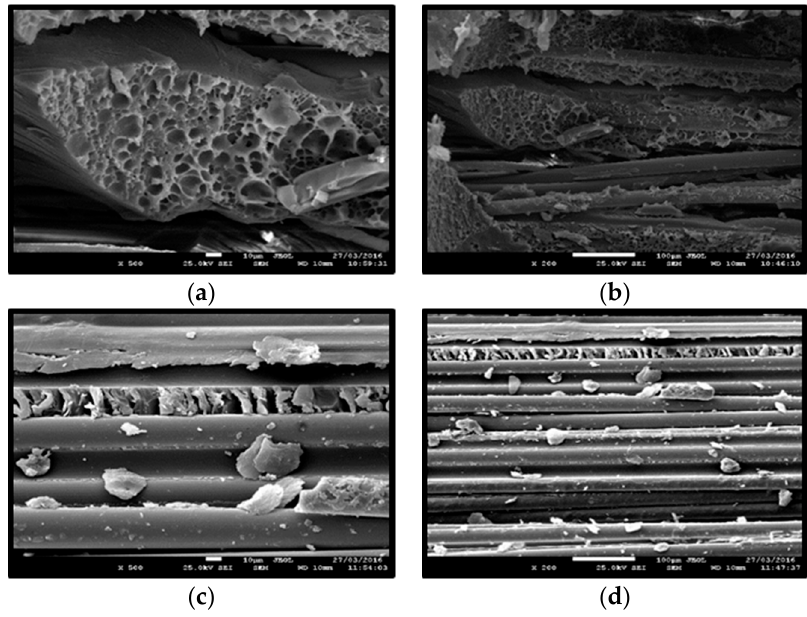
Figure 17. SEM micrograph of GFRP specimen aged in deionized water for 11 months: ( a , b ) section perpendicular to the fiber; ( c , d ) section parallel to the fiberglass filament.